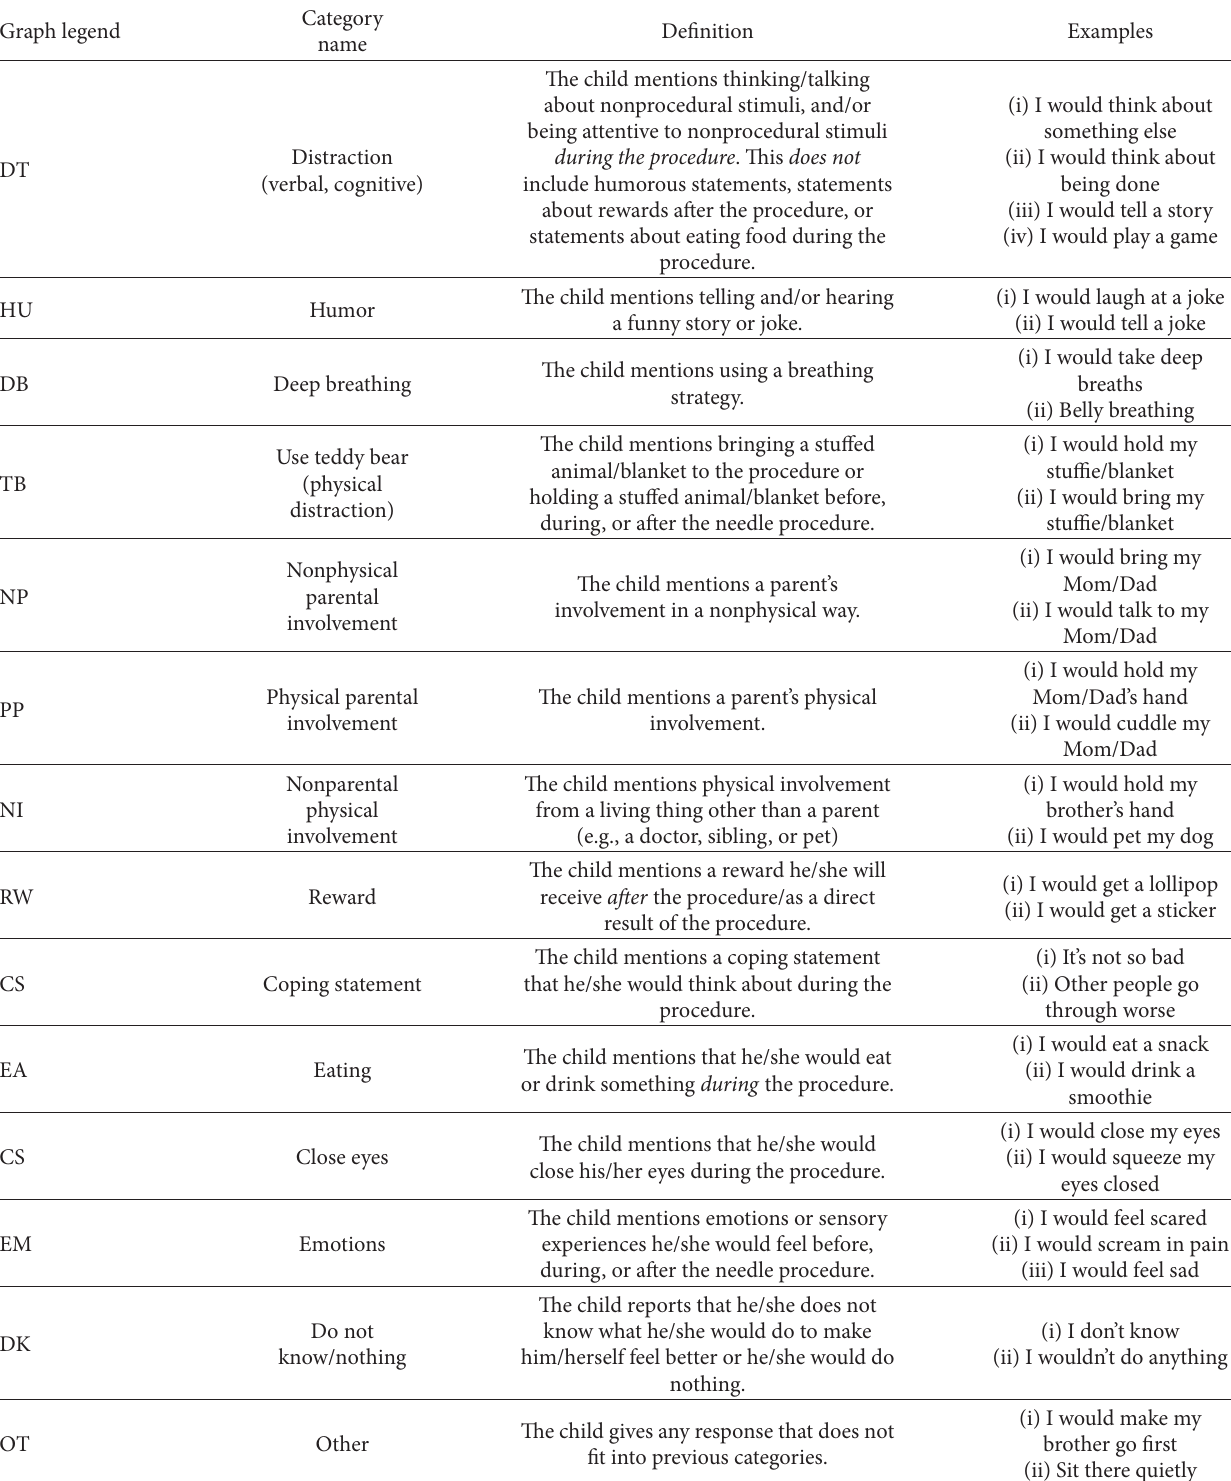
Table 2: Coding categories for participants’ self-reported coping